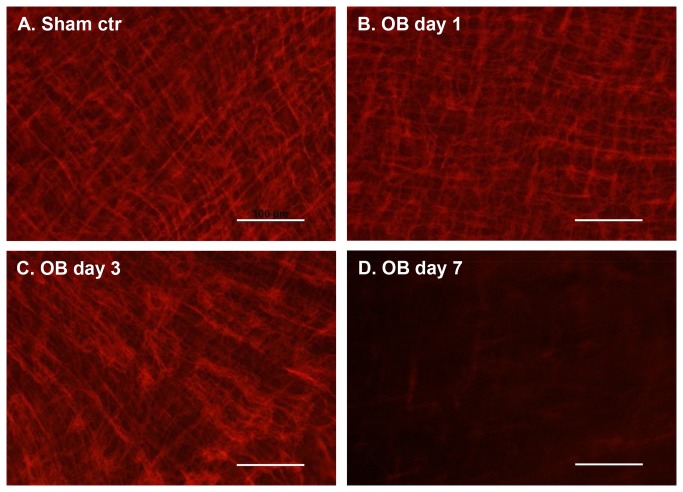
Time-dependent changes of ICC network (ICC-MY) in partial colon obstruction in mice (day 1 to day 7).ICC is labeled with immunofluorescence staining of c-Kit, a tyrosine kinase membrane receptor that is characteristic of the ICC. Representative images in A-D were captured ICC-MY staining in the colon segment proximal to obstruction band in wild-type mice with sham operation (A) and obstruction (OB) for 1 (B), 3 (C), and 7 days (D). Note that there is a significant reduction in the expression of c-Kit staining ICC by day 7 of obstruction. Images shown are representatives of three independent experiments. Calibration bars = 100 µm.